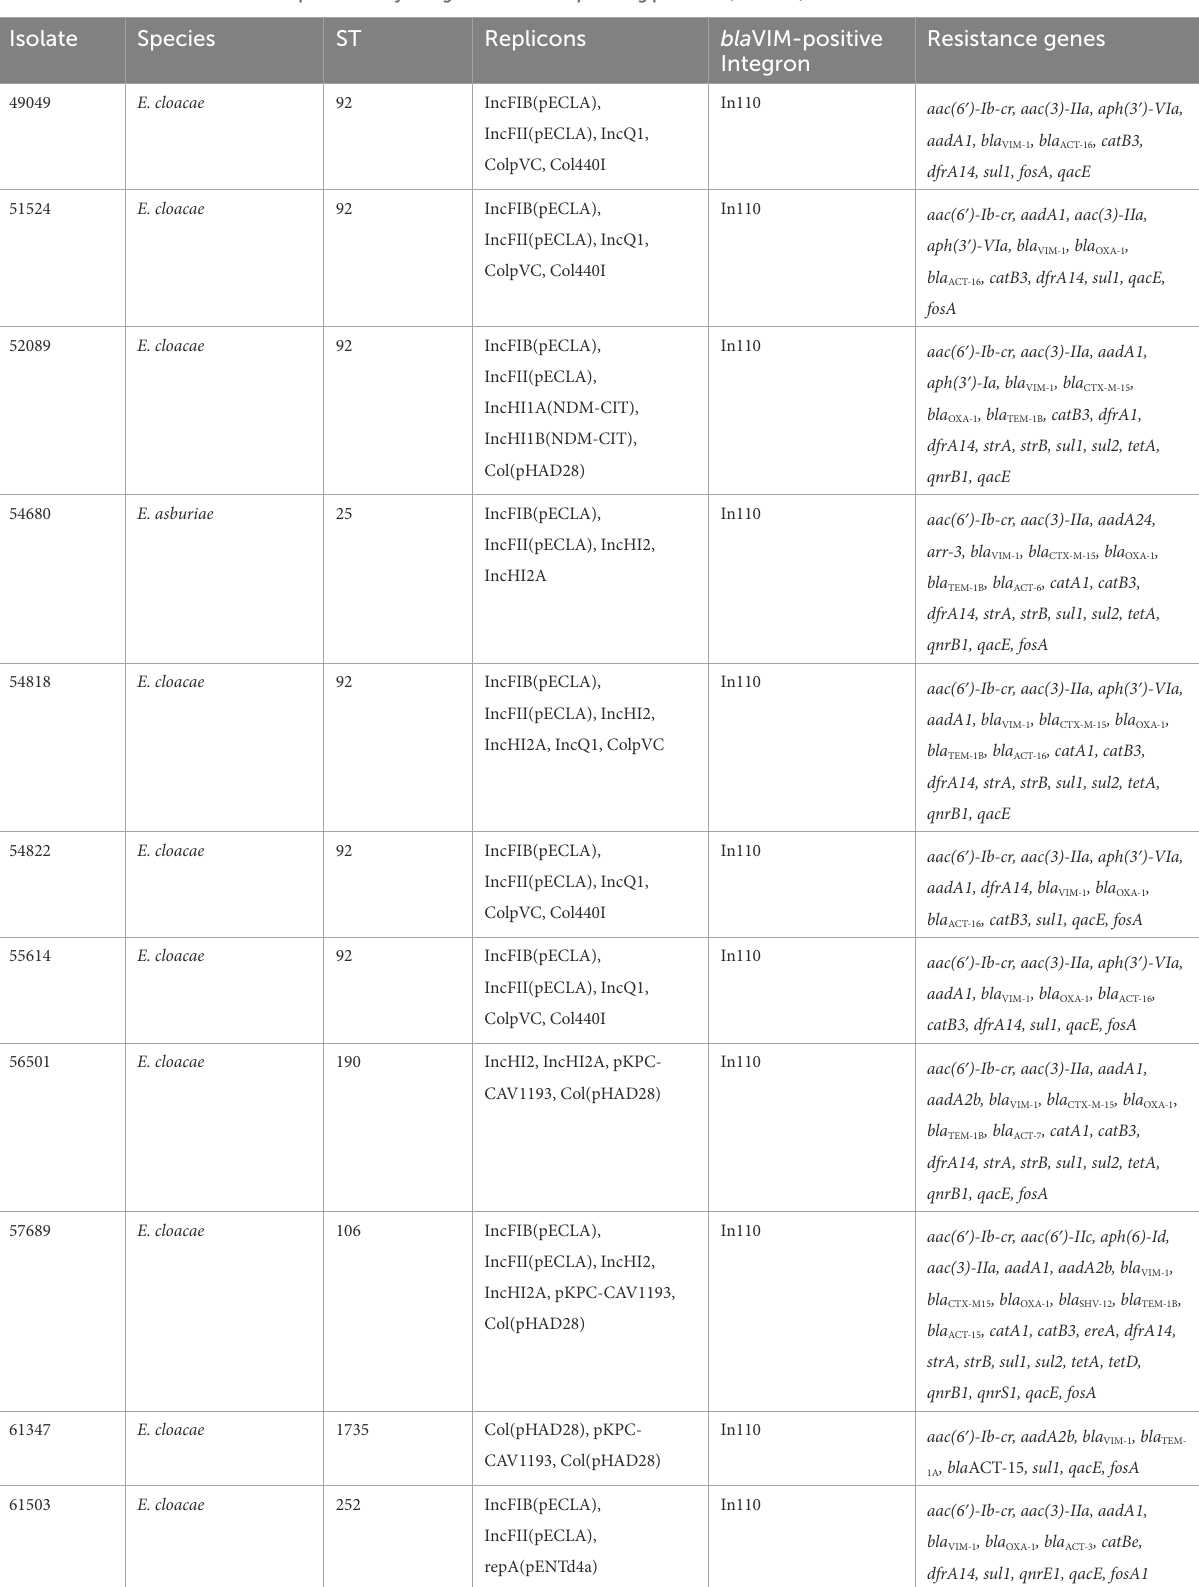
TABLE 2 WGS data of the isolates sequenced only using short reads sequencing platform (illumina).